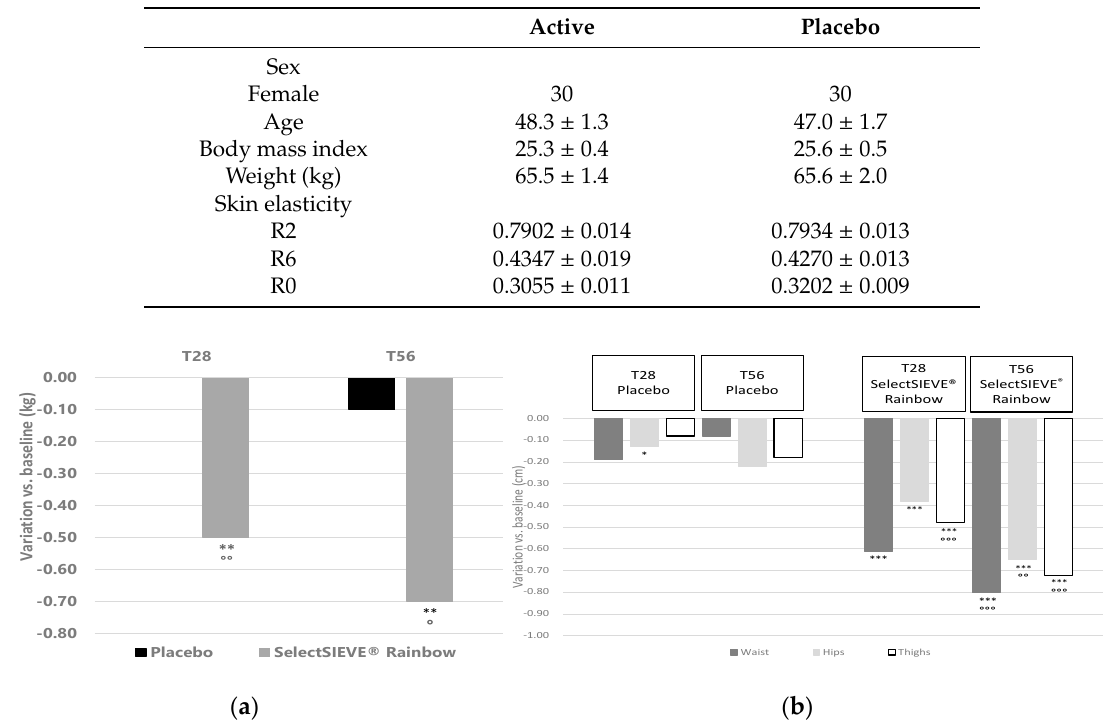
Table 3. Emographic and baseline characteristics.